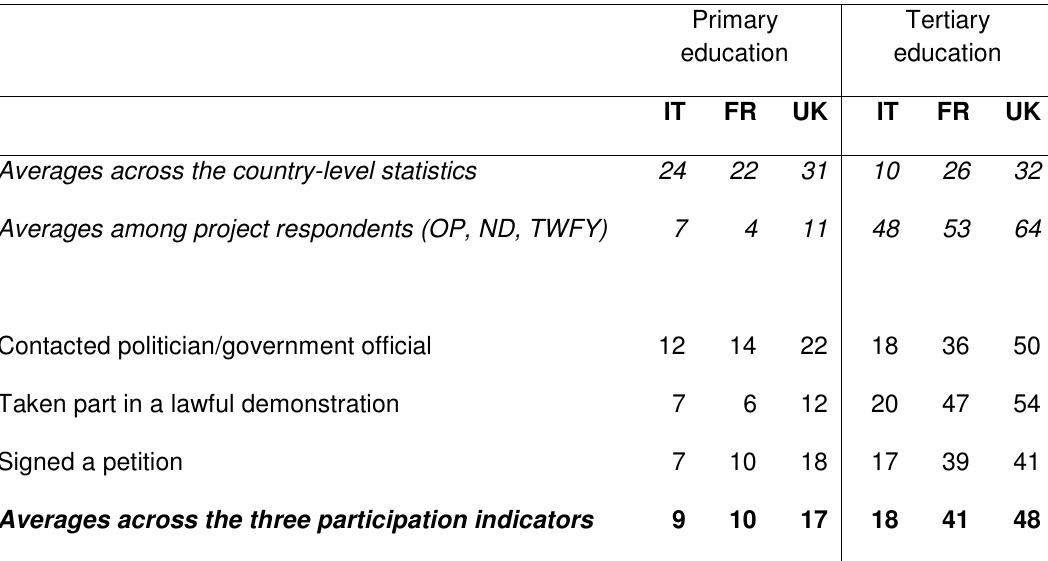
Table 2. The share of persons with (i) less than lower secondary education and (ii)